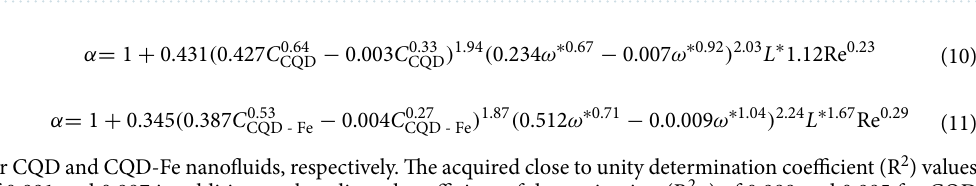
Figure 13. Comparison of the predicted and experimental Sherwood